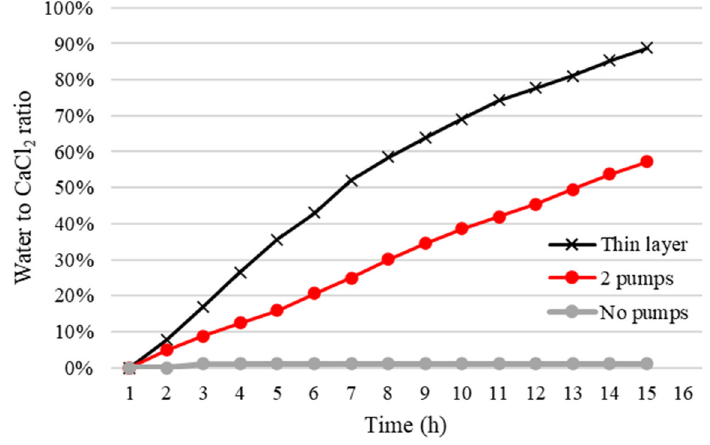
Figure 6. The effect of a thin layer and air pumps on CaCl 2 absorption rate.